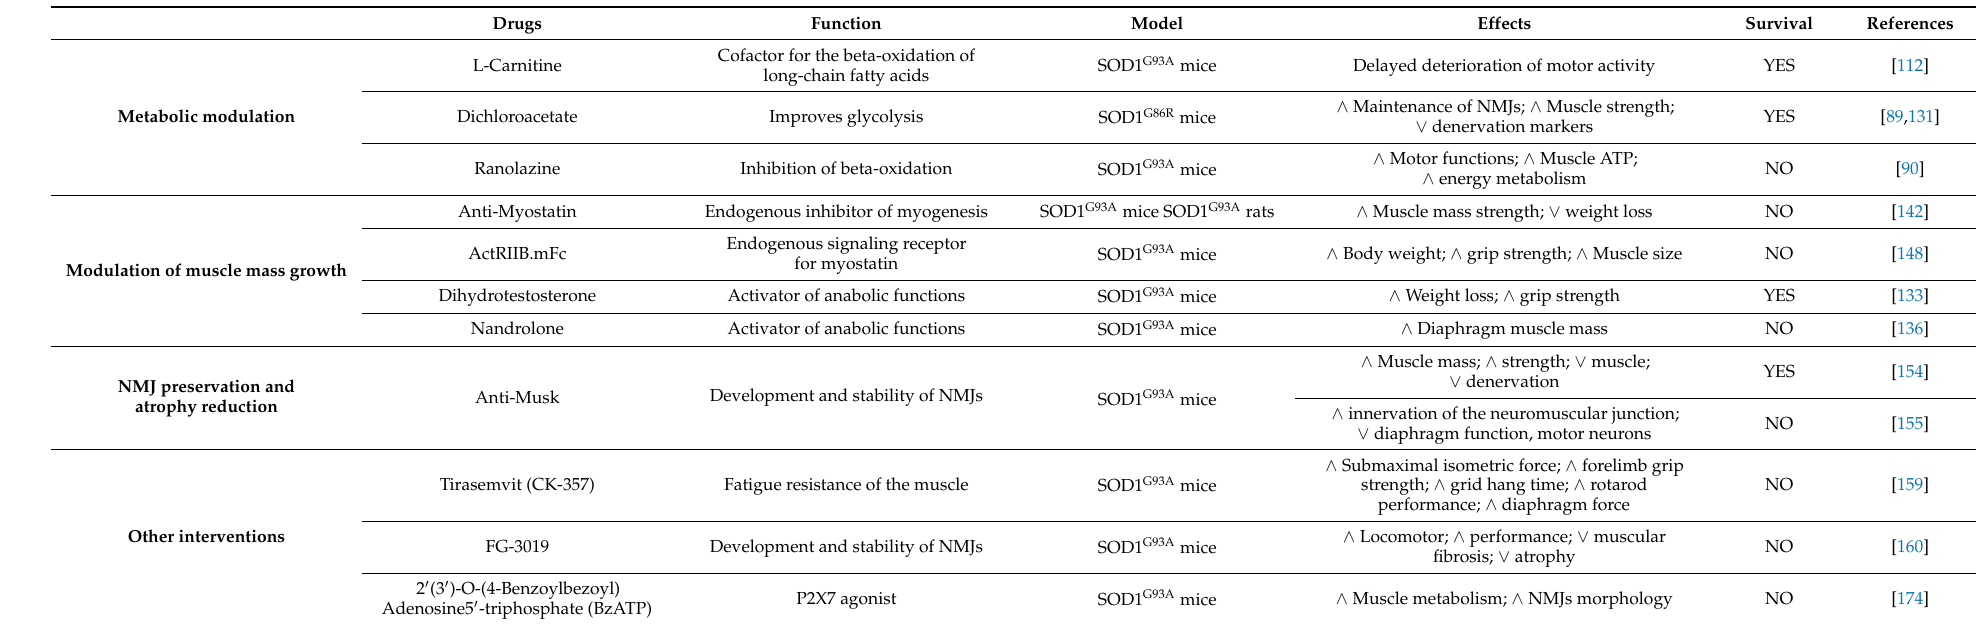
Table 2. Preclinical pharmacological